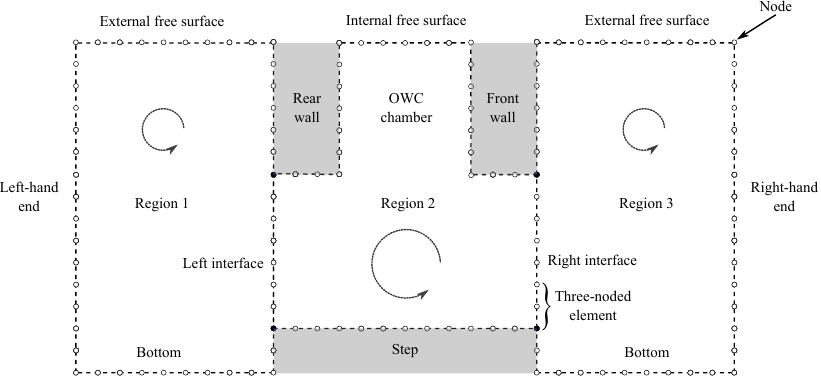
Figure 3. Meshing and matching of the regions with nodes arranged in an anti-clockwise